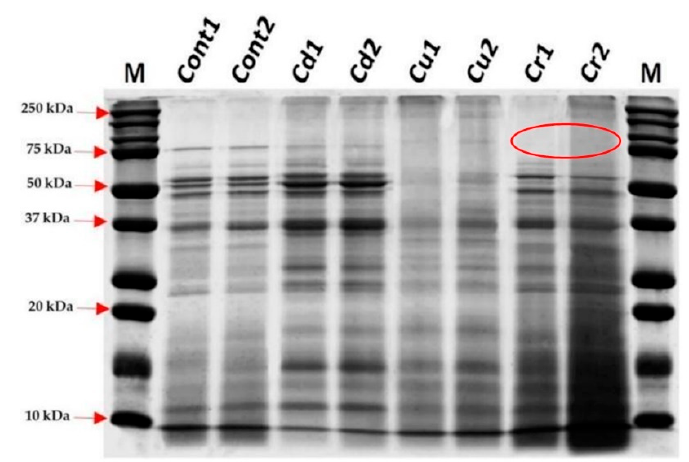
Figure 5 . Protein profile of Y. lipolytica AMJ6 under treatment with heavy metal ions. Cd1 and Cd2: treatment with Cd +2 ; Cu1 and Cu2: treatment with Cu +2 ; Cr1 and Cr2: treatment with Cr +6 , Cont1 and Cont2: proteins without treatment (controls). M: Protein ladder (10-260 kDa Thermo Fisher Scientific). Twenty-five micrograms of protein was added to each lane. The samples treated with Cr +6 showed an absence of bands of high molecular weight in comparison to the control (red circle).